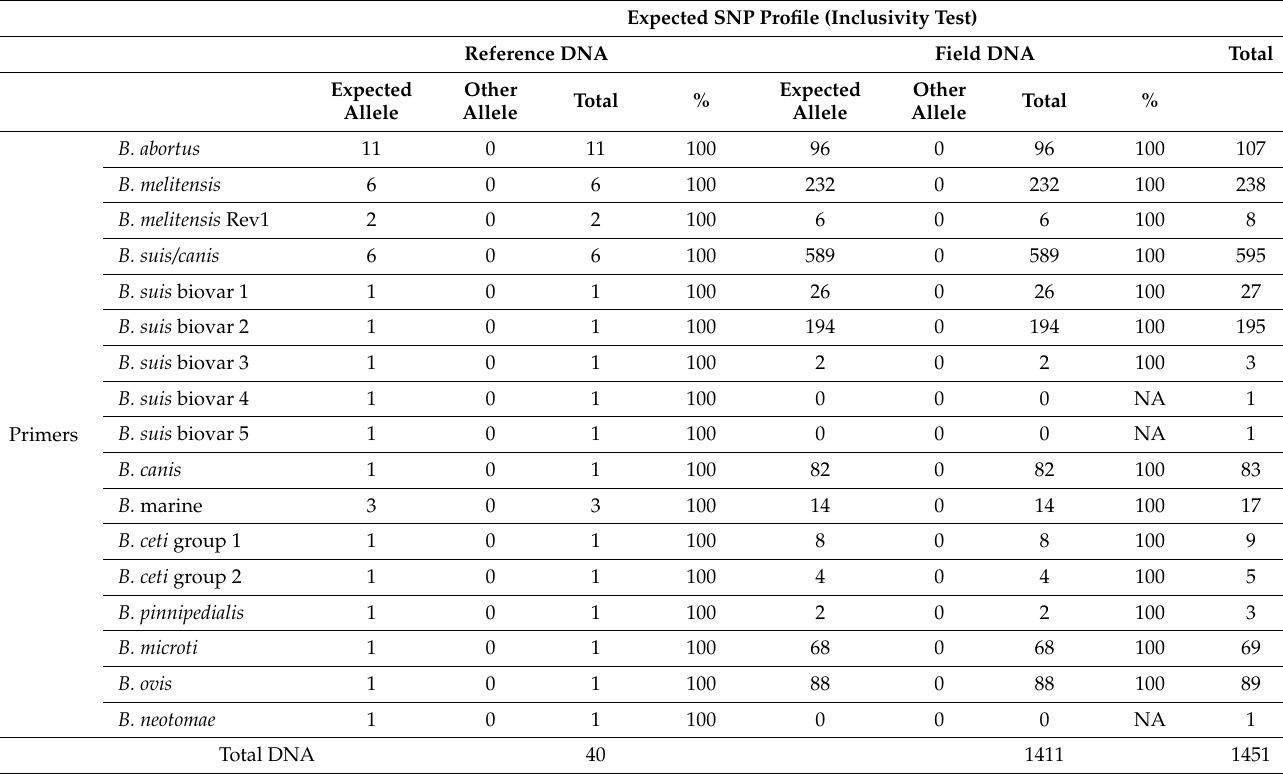
Table 2. Results of inclusivity tests.